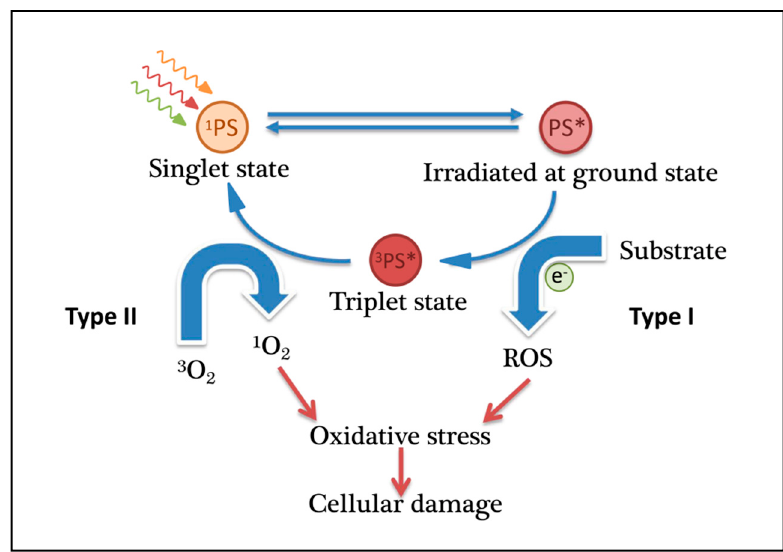
Figure 1. Principle of photodynamic therapy (PDT).